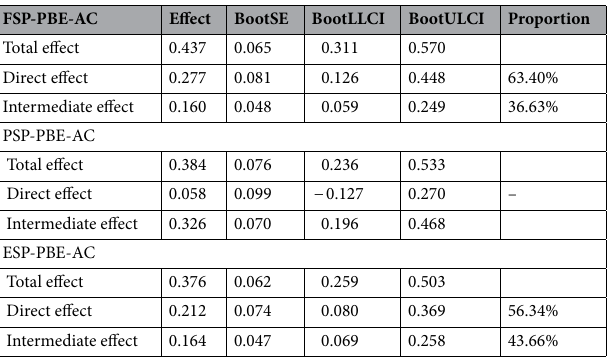
Table 6. Total, direct, and intermediate effects. Data sources: Calculation and arrangement of this paper.